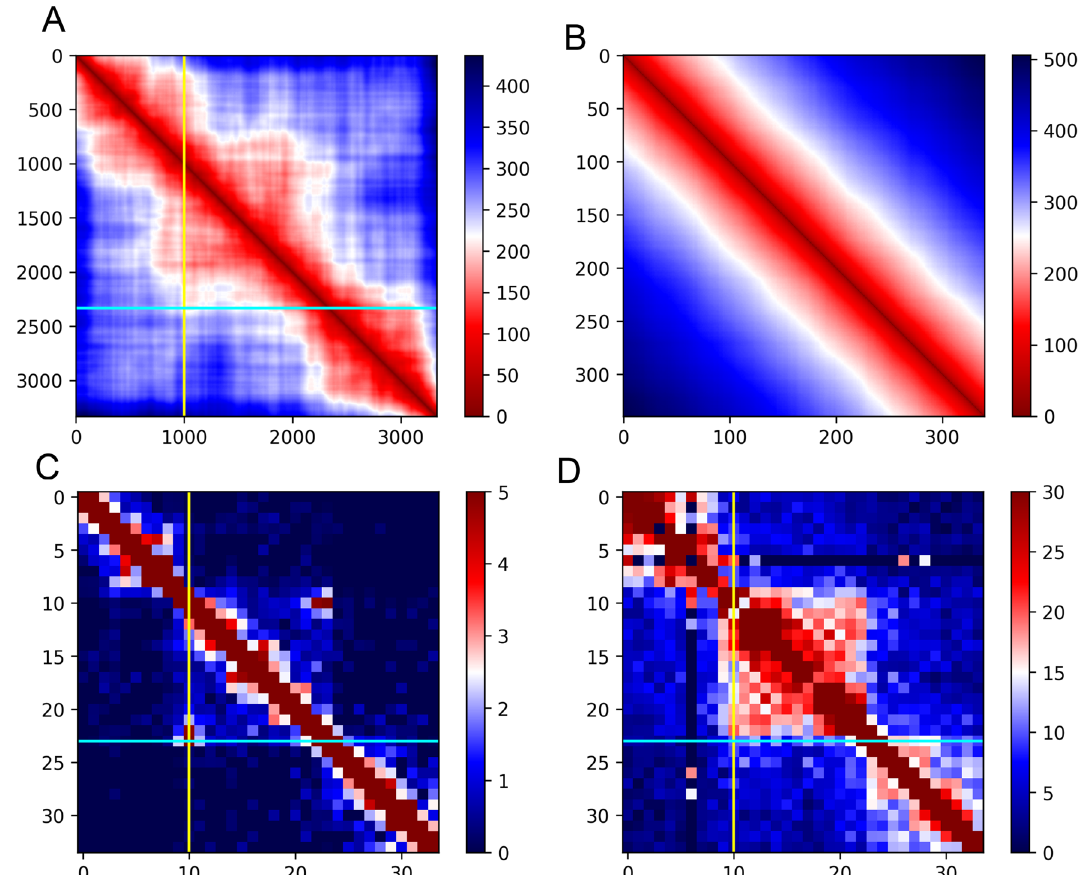
Figure 3. Comparison of average distance heatmaps and genomic interaction heatmaps. Each map shows target chromatin region (chr14:23,016,000–23,049,000). ( A ) Average distance [nm] heatmap calculated from all the 3D models with marked loop anchor positions (yellow line for bead 1000: chr14:23,026,030, cyan line for bead 2331: chr14:23,039,340). ( B ) Average distance [nm] map from simulated control experiment: self-avoiding random walk polymer models. Scale bar in ( A ) and ( B ) represents the linear distance between model beads with red representing the shortest distance and blue the longest. ( C ) ChIA-PET interaction heatmap, 1 kb resolution. ( D ) In situ Hi-C interaction heatmap, 1 kb resolution. Scale bar in ( C ) and ( D ) represents the interaction frequency from ChIA-PET and Hi-C data respectively with red representing the highest frequency and blue the